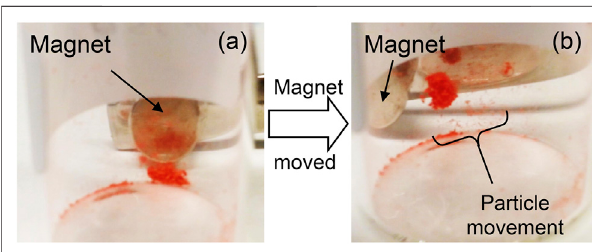
FIGURE 13 | (A) The dyed magnetic capsules and external magnetic before movement, and (B) the particle movement caused as the position of the magnet was